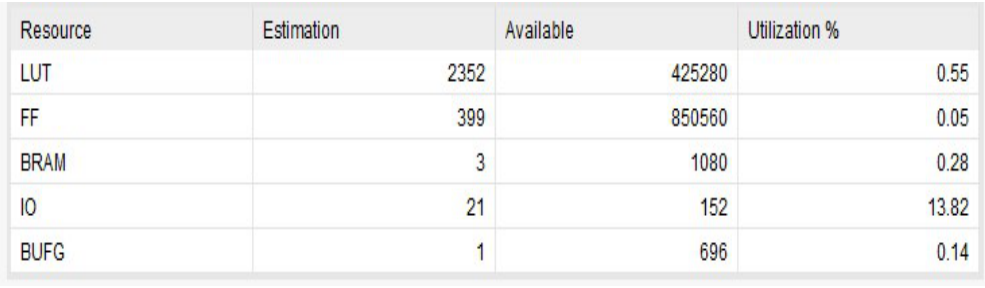
Figure 22. Resources used in the